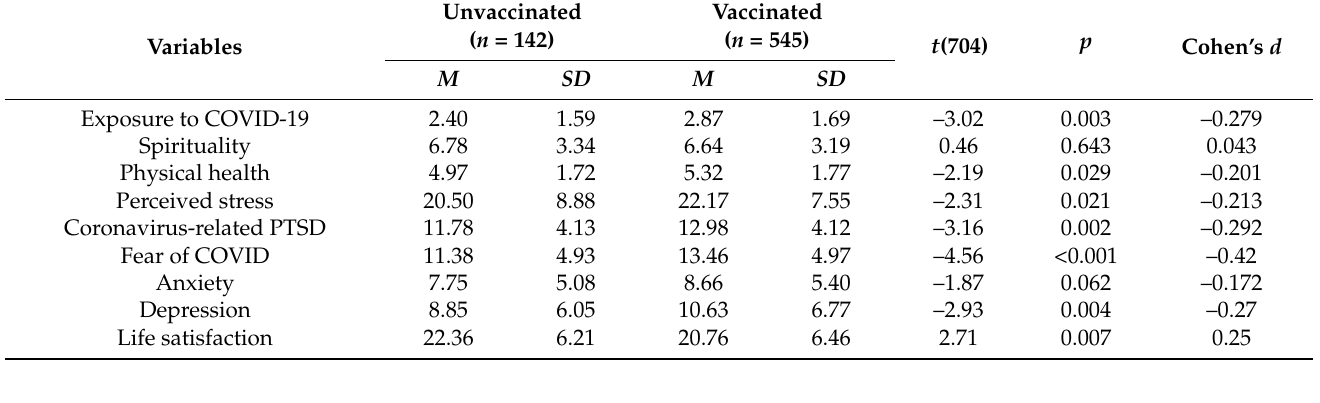
Table 2. Student’s t -test for comparison of vaccinated and unvaccinated university students relative to well-being dimensions.